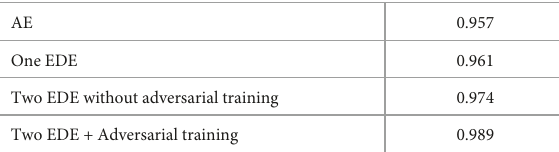
TABLE 5 Ablation study for proposed model performed on